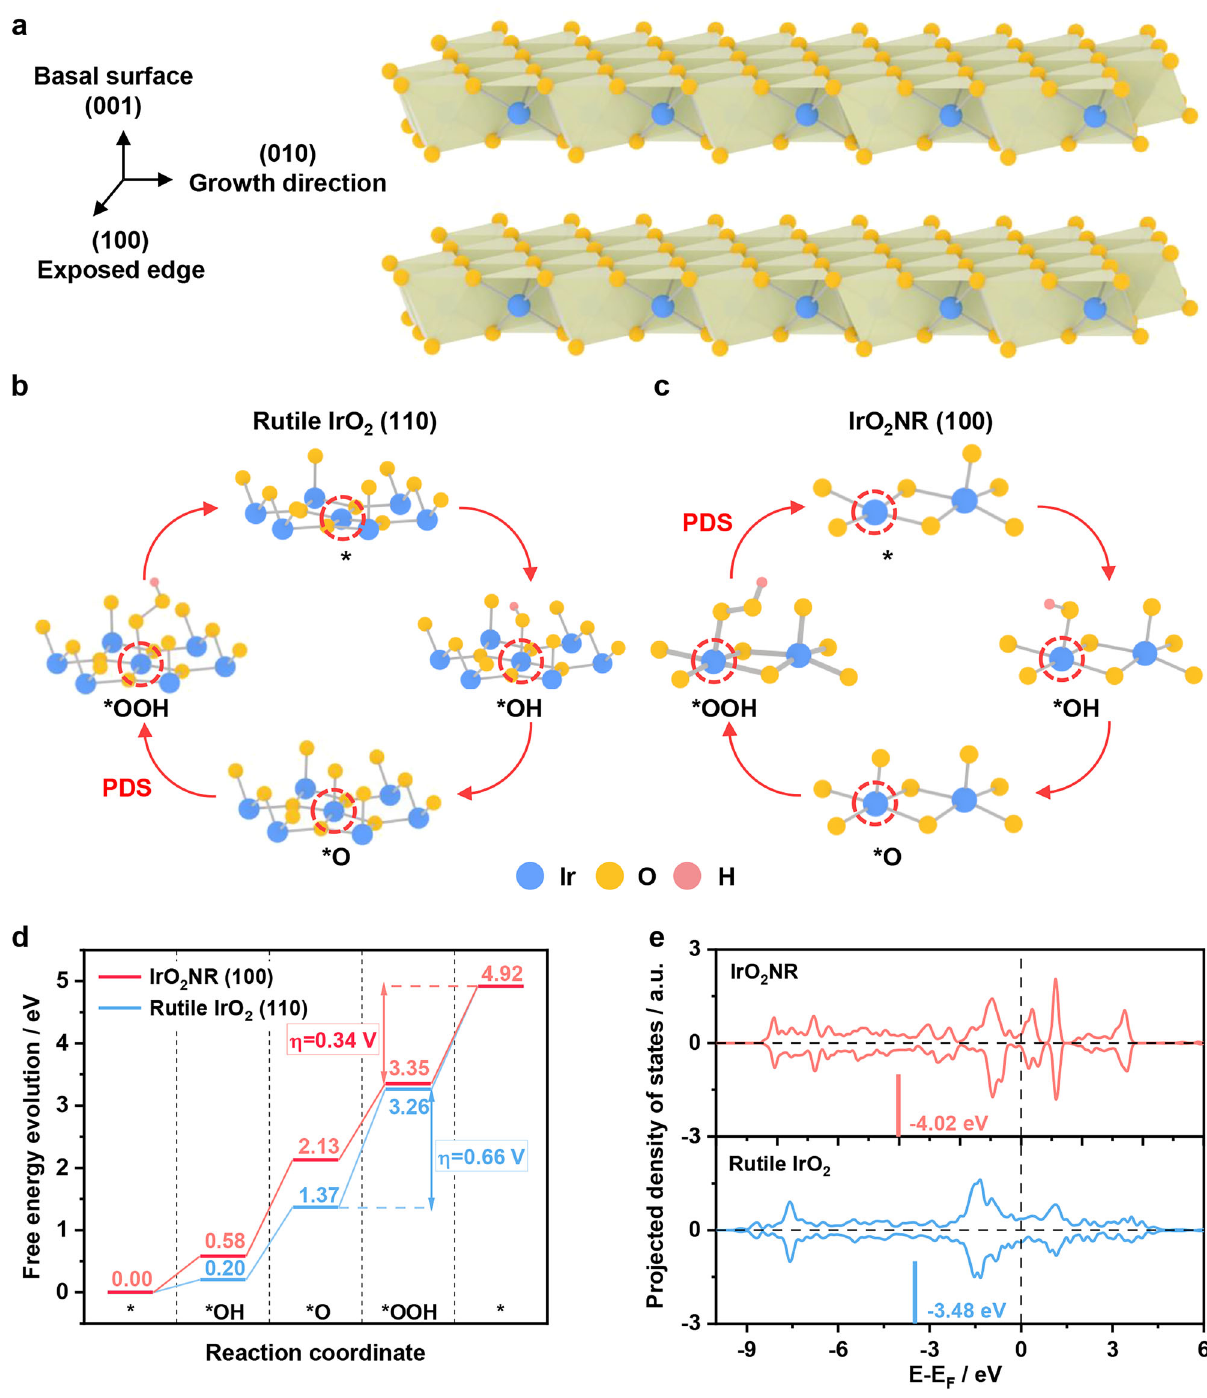
Fig. 4 | Theoretical analysis ofthe OER for the IrO 2 NR. a Crystal structure of the IrO 2 NRwithanexposededgeforthe(001)planeduringtheoreticalcalculation.The reaction mechanismsof the OER over the ( b ) Rutile IrO 2 (110) and ( c ) IrO 2 NR(100) samples. d Corresponding 4e - thermodynamic diagram of free energy evolution.